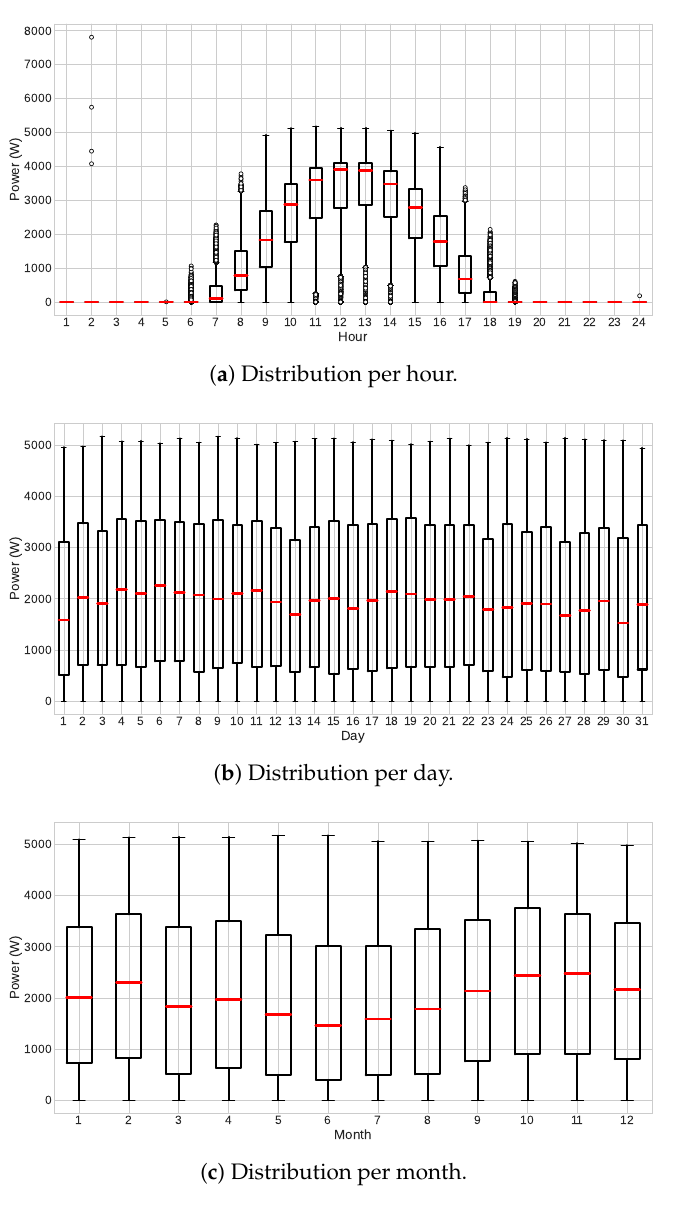
Figure 5. Distribution of the photovoltaic power values from the database, considering ( a ) the distribution in hours, ( b ) the distribution in days (daytime values only), and ( c ) the distribution in months (daytime values